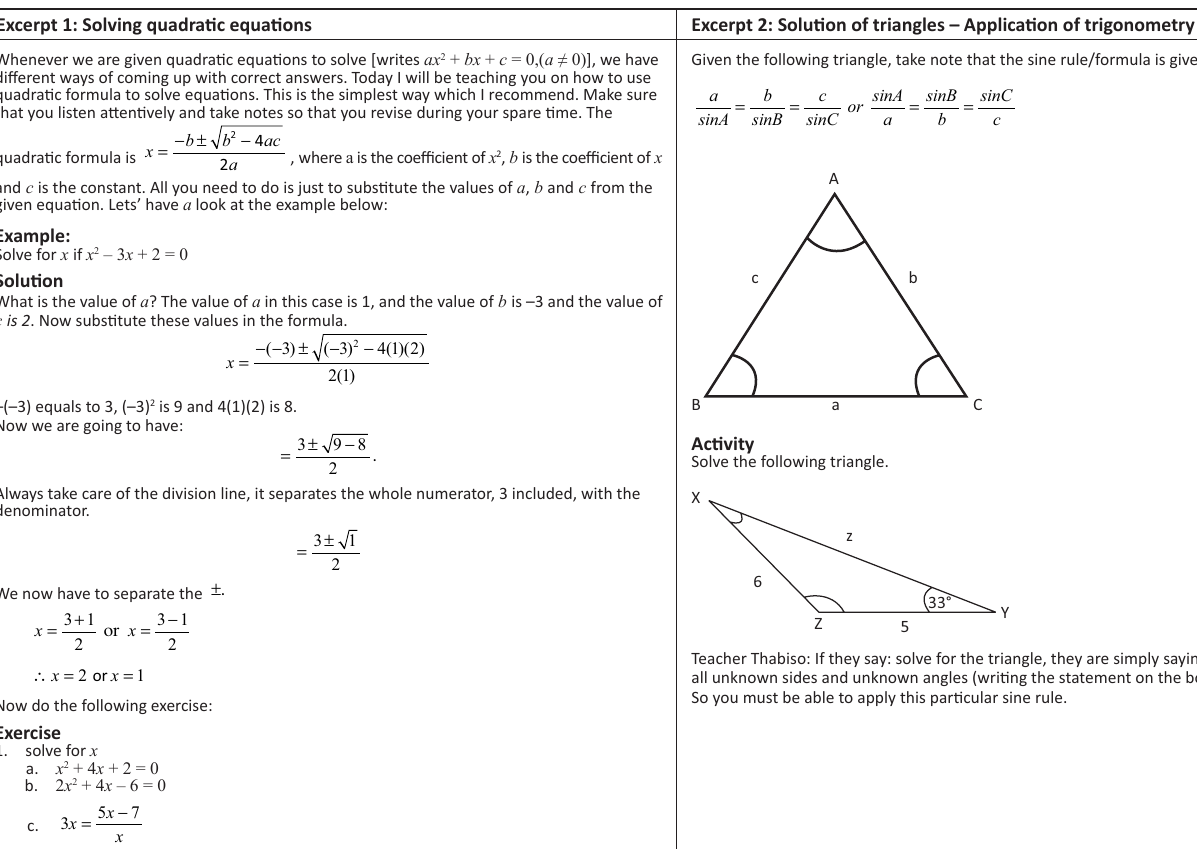
FIGURE 1: Thabiso’s two teaching